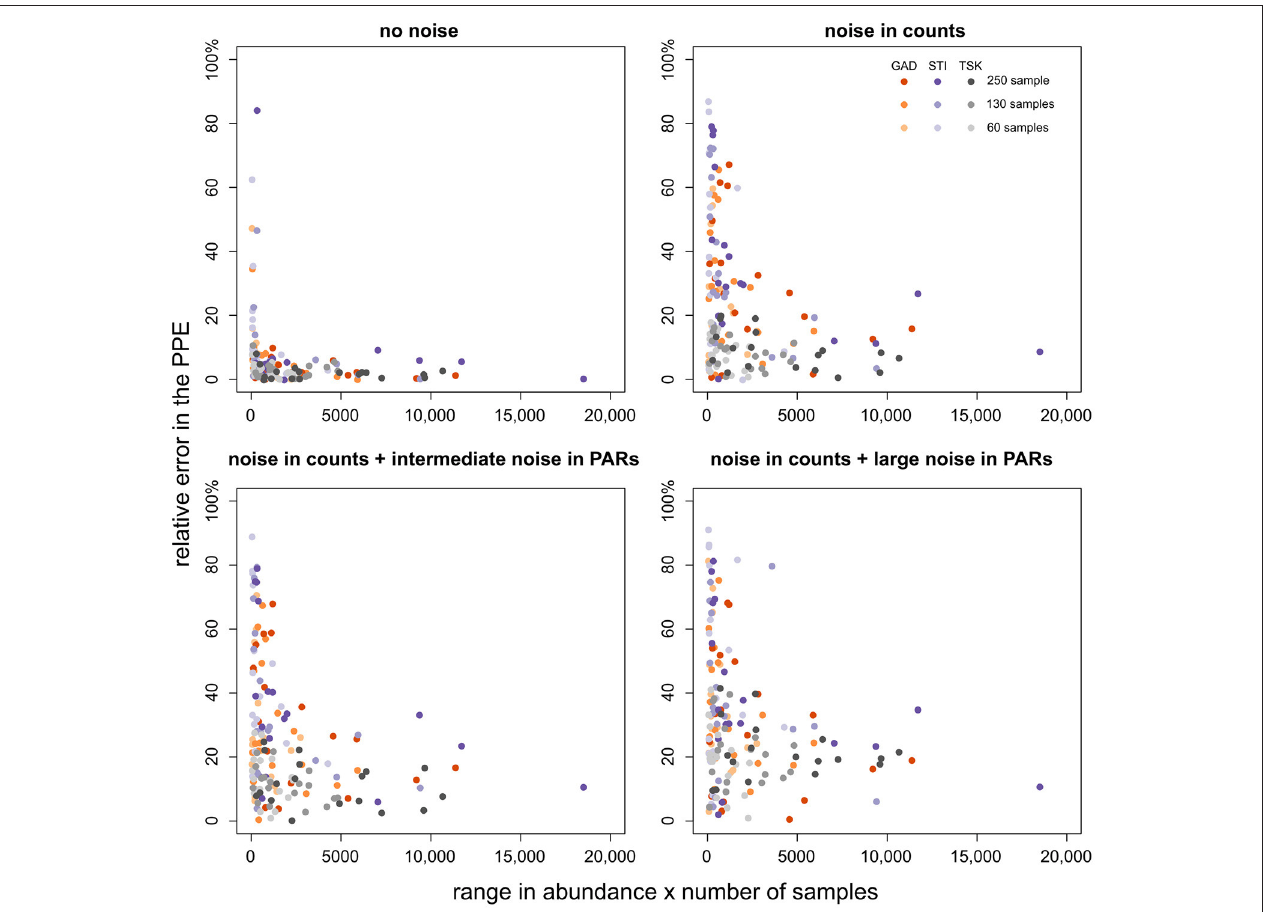
FIGURE 5 | Relative PPE error (y-axis) plotted over the range of values of the respective taxon multiplied by the number of samples (x-axis). PPE error is calculated as the absolute difference between the median from 100 model runs and true pollen productivity divided by true pollen productivity ( × 100%). The colors denote the pollen record, shade its